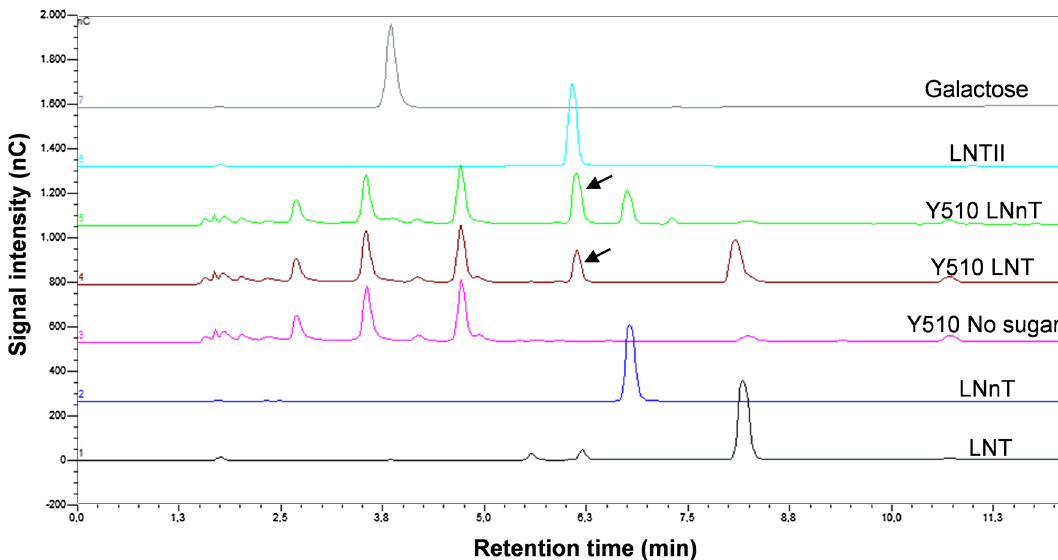
Figure 2. HPLC chromatograms (Dionex system) of the standard compounds LNT (chromatogram 1), LNnT (chromatogram 2), LNTII (chromatogram 6) and galactose (chromatogram 7), and culture supernatants from Bifidobacterium dentium Y510 grown on MRS basal medium without sugar (chromatogram 3), with LNT (chromatogram 4) or LNnT (chromatogram 5). The arrows showed the LNTII present in the culture supernatants. LNT lacto- N -tetraose, LNnT lacto- N -neotetraose, LNTII lacto- N -triose, nC nanoCoulomb.